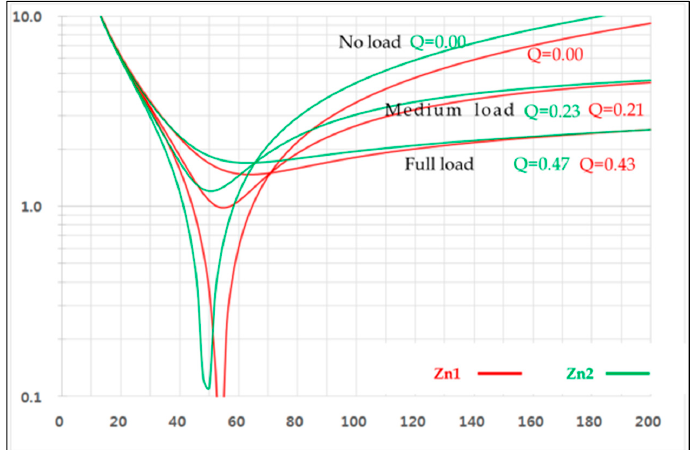
Figure 12. Input–output voltage gain and frequency characteristics of the auto-balancing converter.